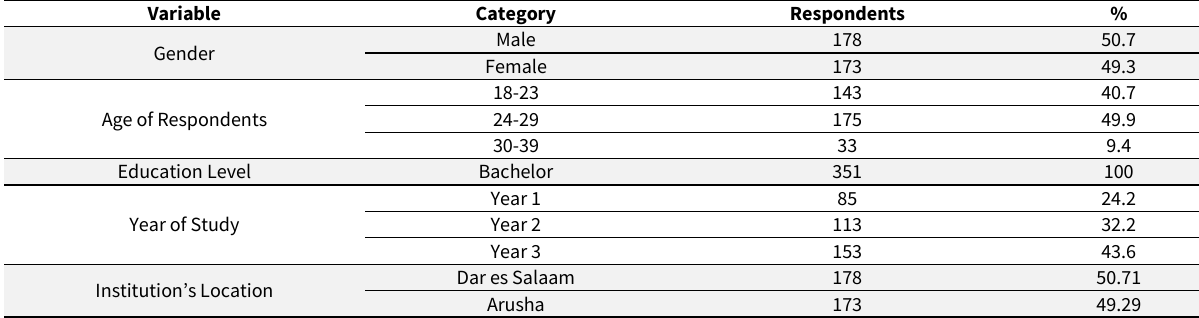
Table 1. Demographic Information of